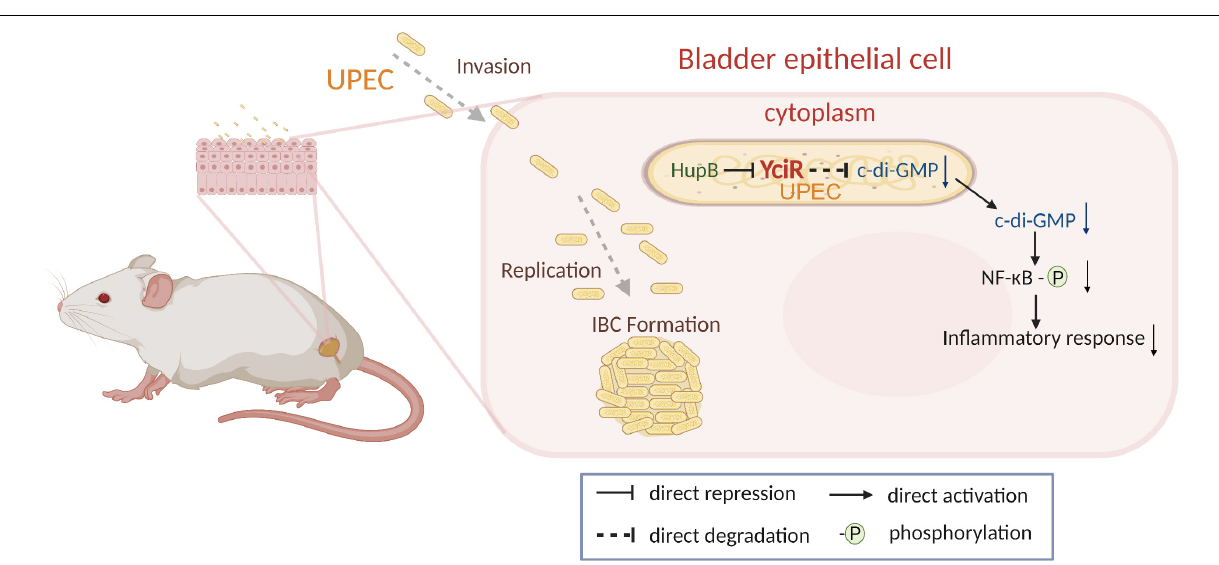
FIGURE 9 | Graphical abstract of YciR-mediated virulence model of uropathogenic Escherichia coli